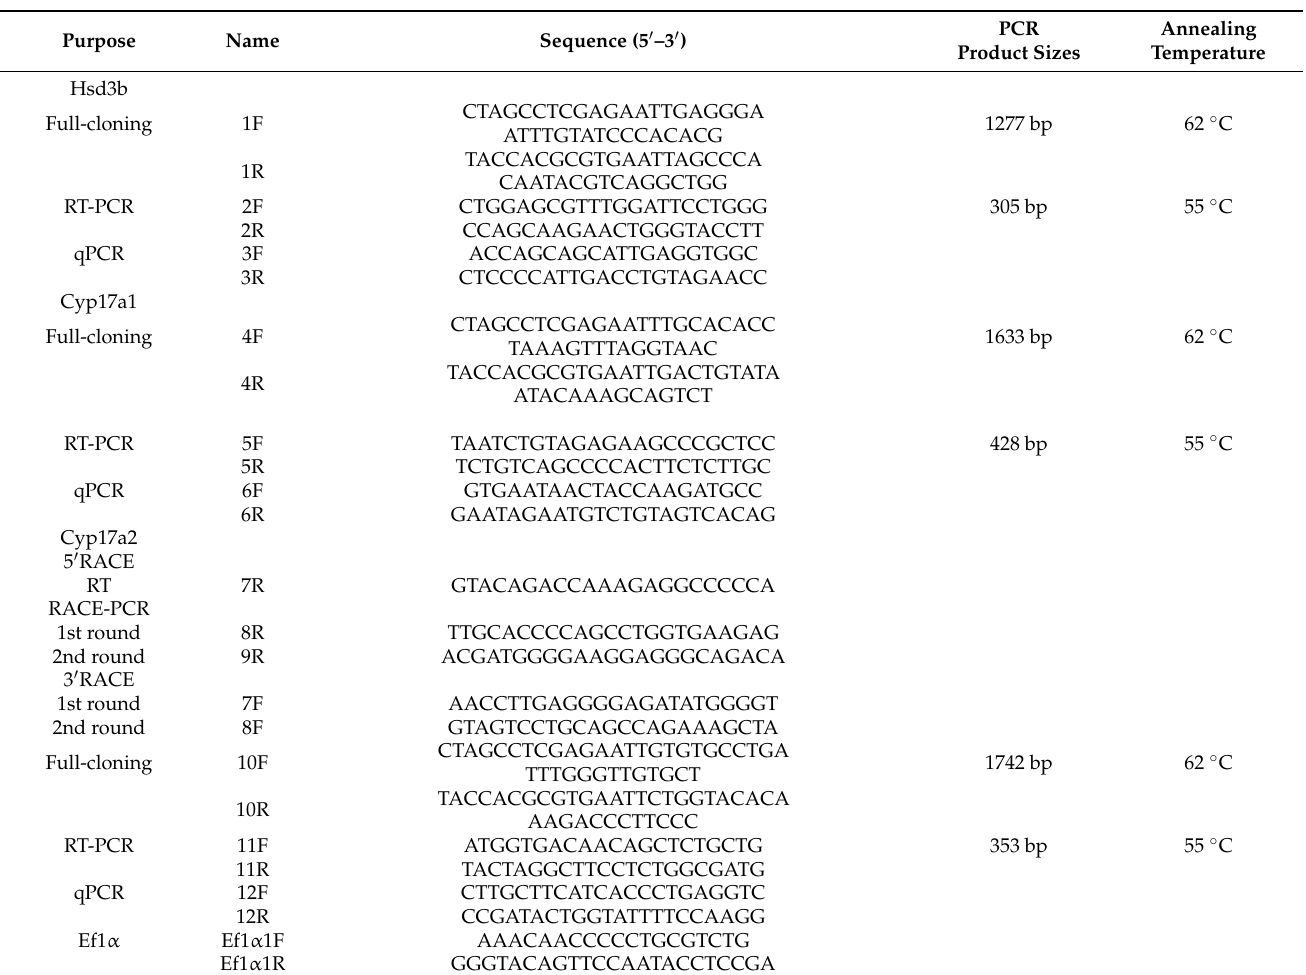
Table 1. Primers used in this